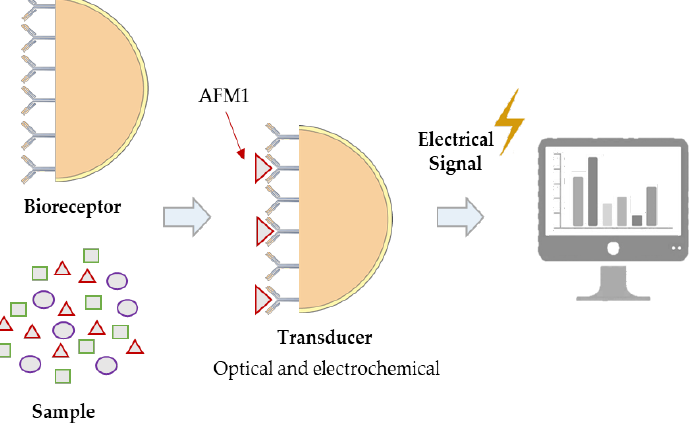
Figure 6. General basis parts of immunosensors.